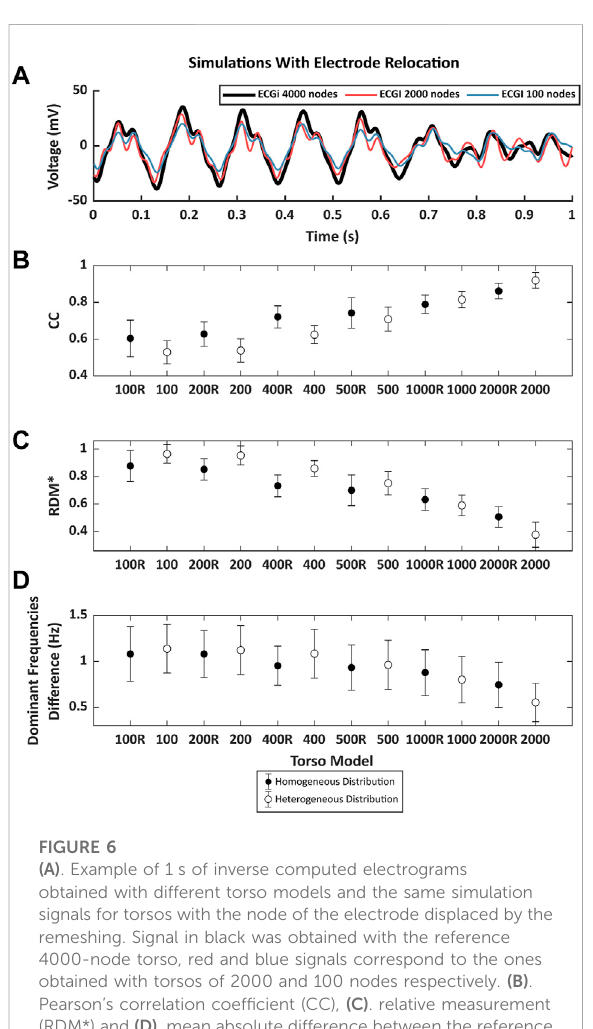
FIGURE 7 Time metrics obtained comparing the inverse computed electrograms 25 atrial fi brillation patients of the reference and the signals obtained with different torso models with the node of the electrode displaced by the remeshing. Points in black represent the torsos in which the distribution of the nodes is homogeneous and white points represent the torso with nodes heterogeneously placed. (A) . Pearson ’ s correlation coef fi cient (CC) and (B) . Relative difference measurement (RDM*). (C) . Mean absolute difference between the reference DF between torso models and from 100 to 1,000